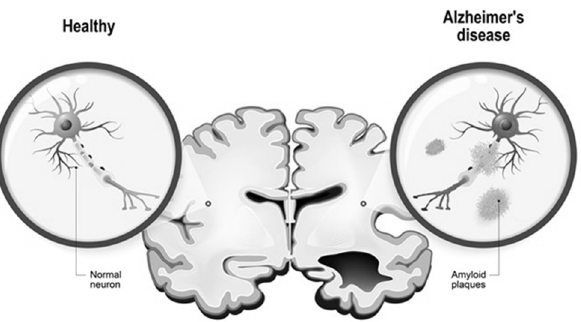
Figure 3. Human brain, in two halves: healthy and Alzheimer’s disease. Healthy neuron and neuron with amyloid plaques. with amyloid